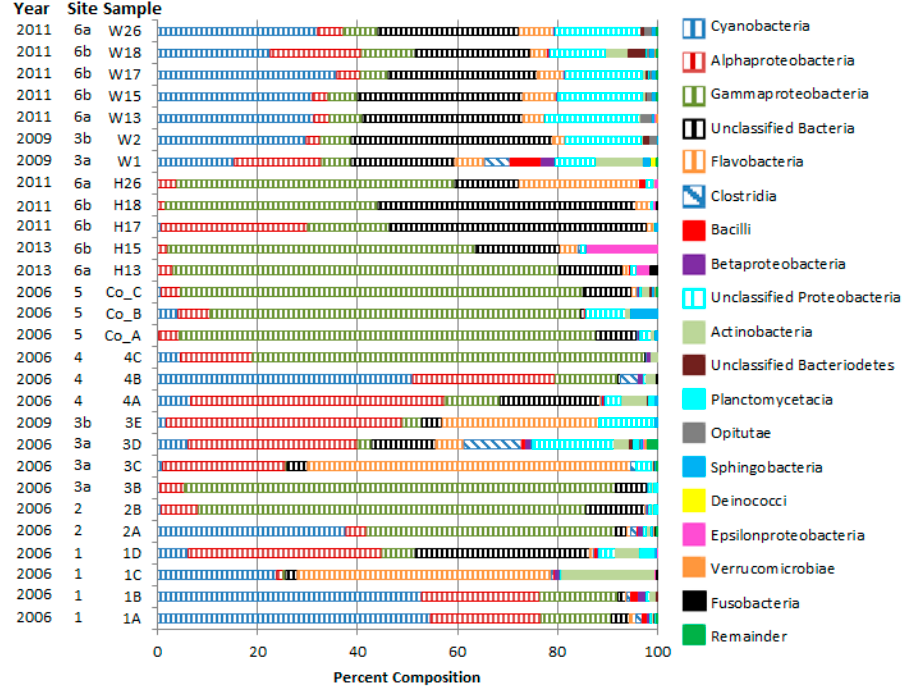
Figure 2. Class level bacterial community composition of A. elisabethae and seawater samples.